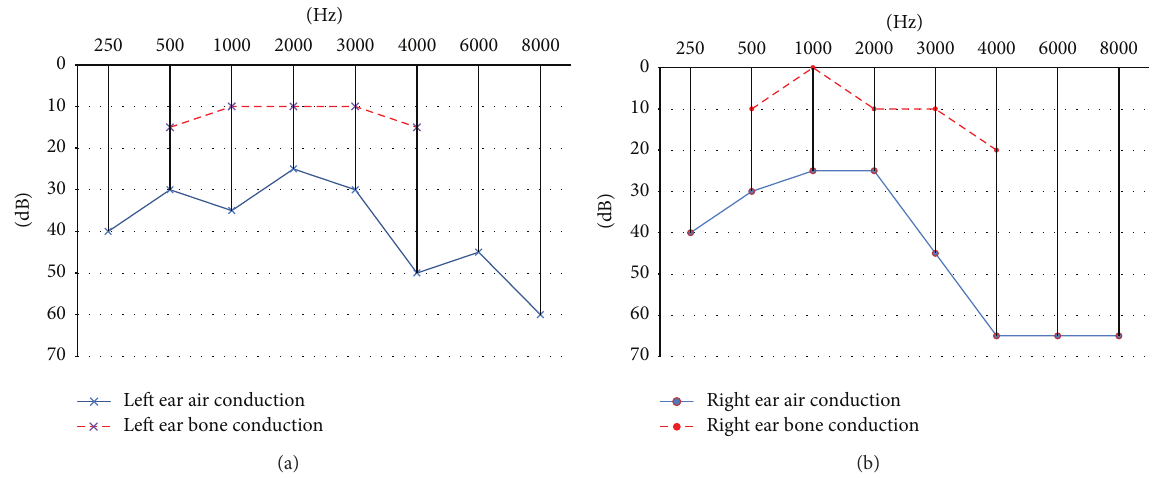
Figure 4: Control pure-tone audiometry, performed after four months of treatment, description in the